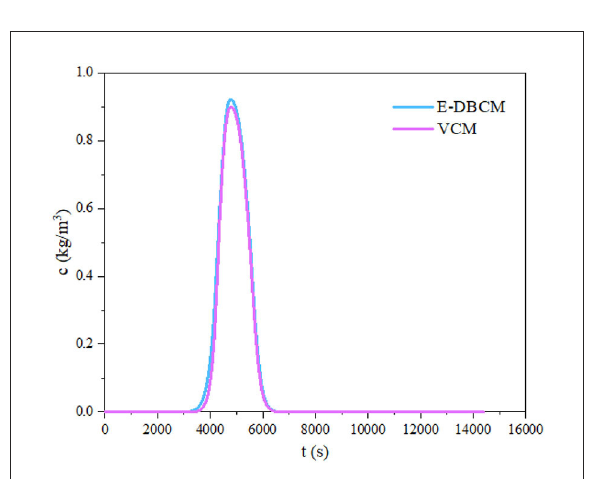
FIGURE8 The pollutant concentrations obtained from different